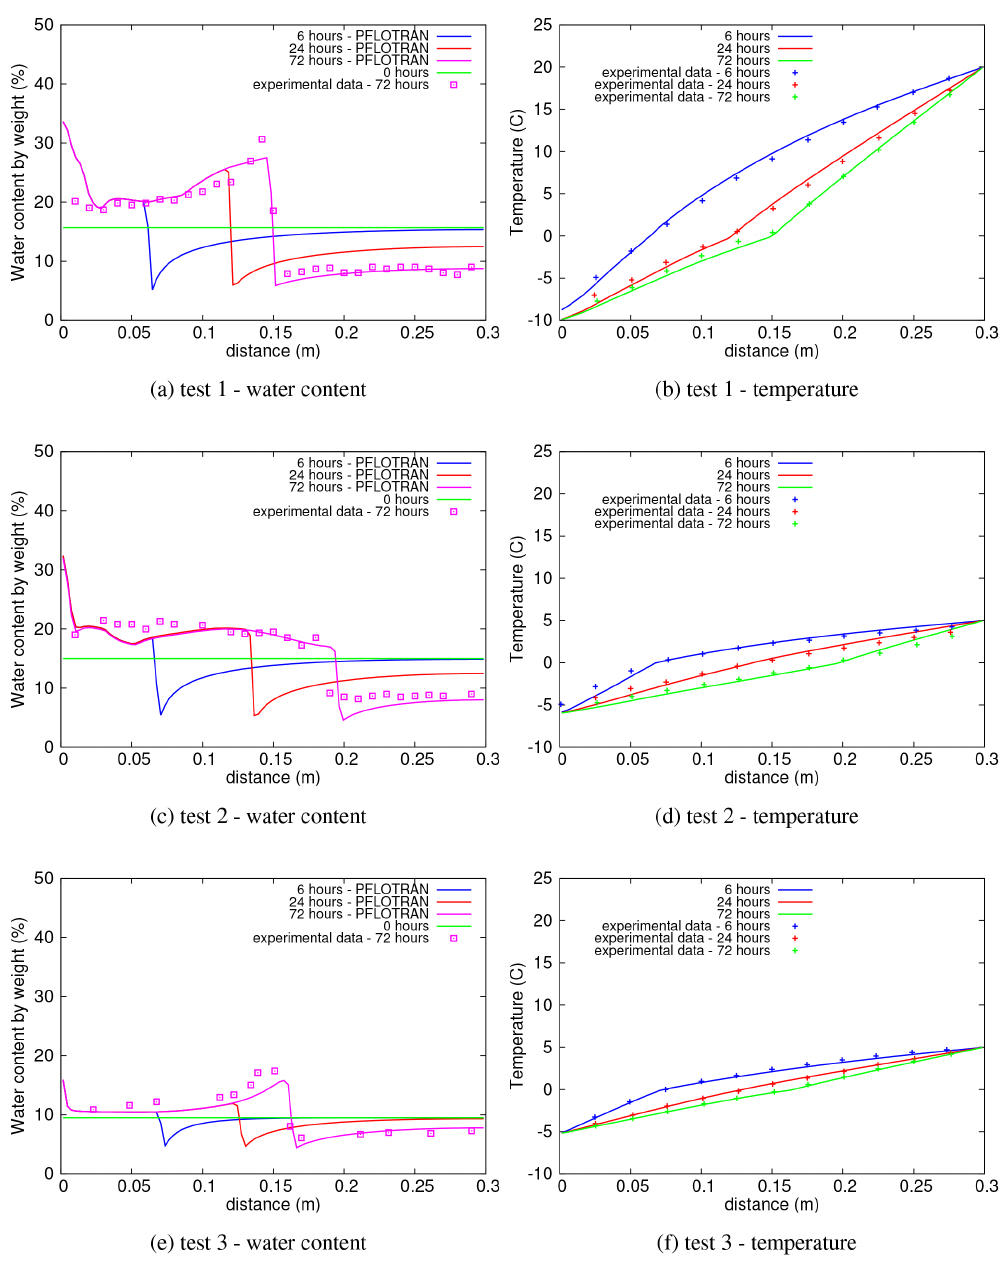
Figure 2. Comparison of simulated results from PFLOTRAN with laboratory experiments of Jame and Norum (1980) with simu- lated data shown in solid curves and experimental data shown with points. The parameters used are permeability = 3.5 × 10 − 12 m 2 , thermal conductivity (dry) = 0.25Wm − 1 K − 1 , thermal conductivity (wet) = 2.3Wm − 1 K − 1 , α u = 0.45, α f = 0.95, thermal conductiv- ity (frozen) = 3.6Wm − 1 K − 1 , porosity = 0.5, soil density = 2700kgm − 3 , specific heat = 837Jkg − 1 K − 1 and tortuosity = 0.01. The van Genuchten parameters used were α = 2 × 10 − 4 Pa − 1 and λ =